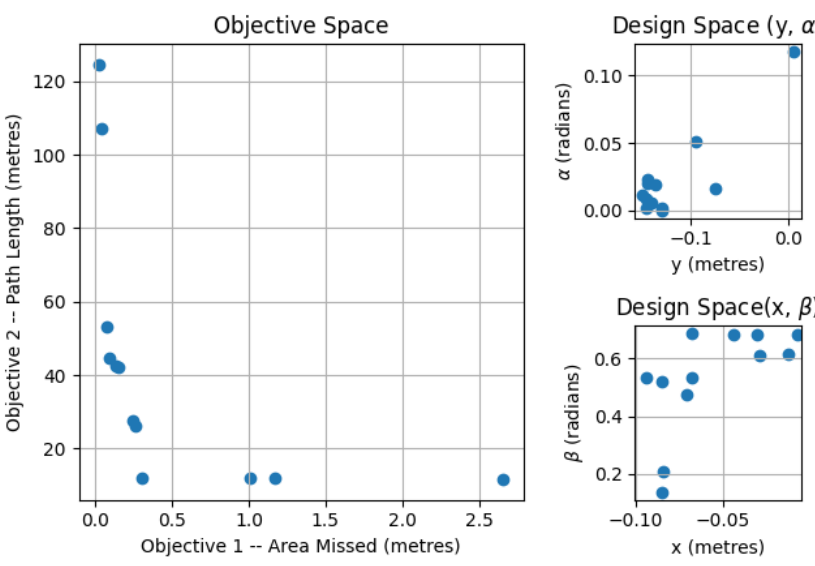
Figure 8. NSGA2 optimization for area size 4 × 2 m with population size =